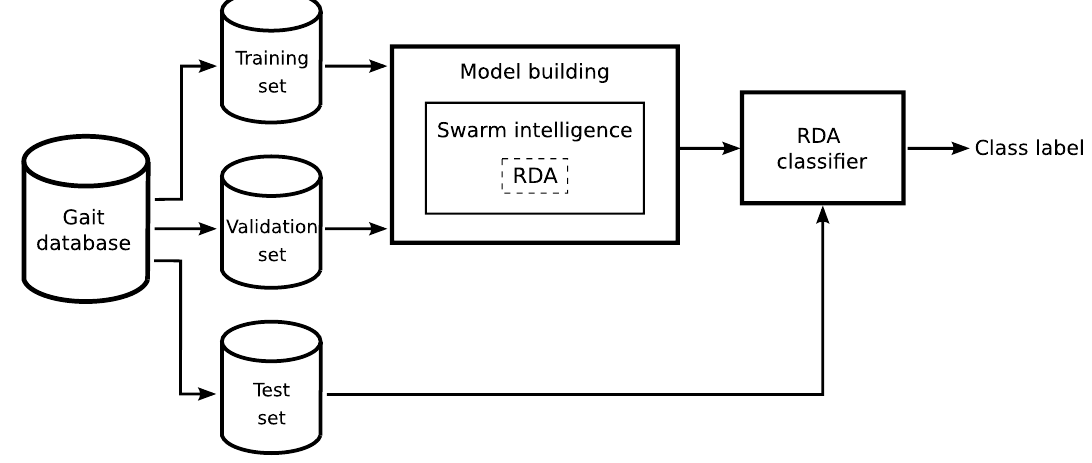
Figure 2. The idea of building the RDA classification